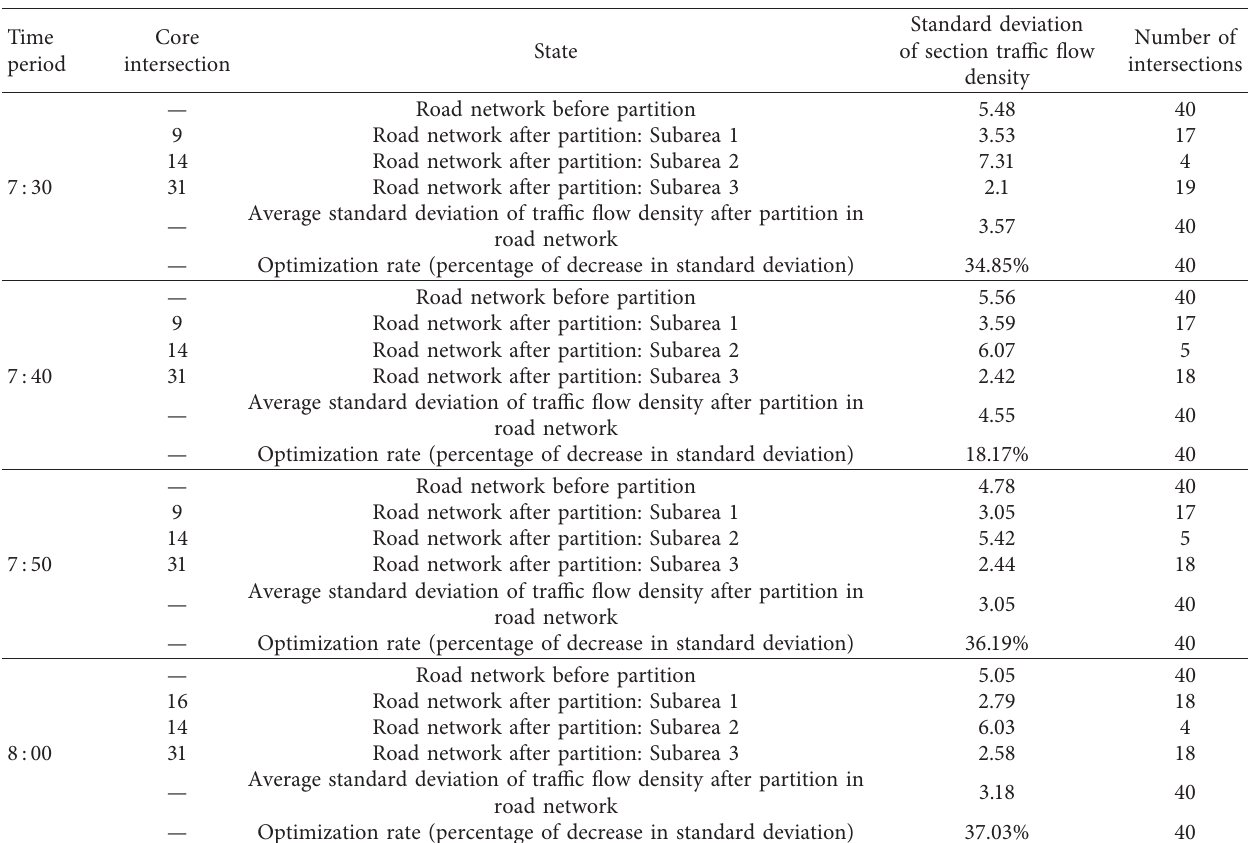
Table 6: Traffic flow density standard deviation before and after dynamic